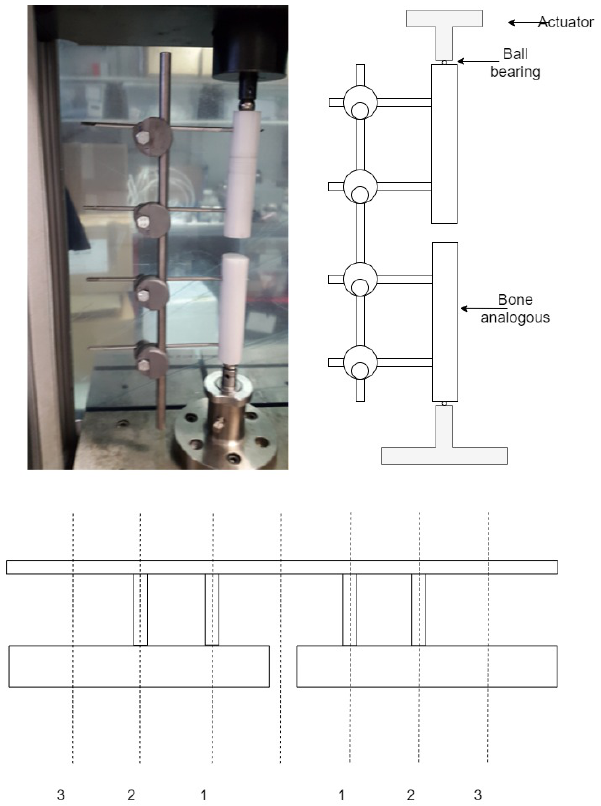
Figure 8. Top : Diagram of system test. Bottom : Pin placement options used in the system test. positions 1, 2, 3 are 45, 90 and 135 mm from the fracture site,